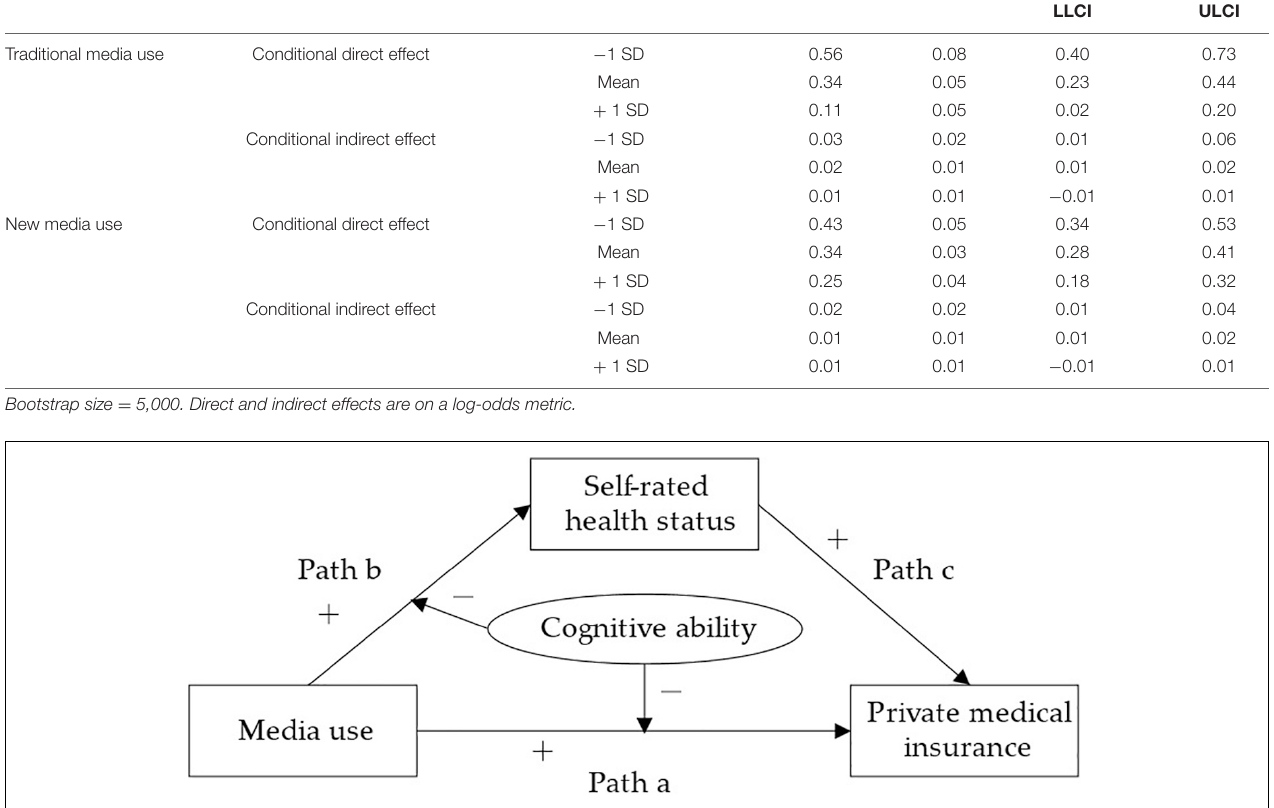
FIGURE 4 | Influence mechanism